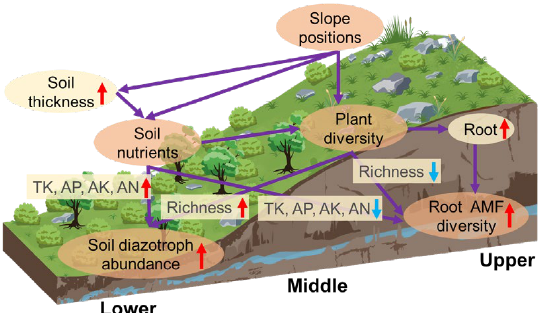
Figure 5. Conceptual model revealing the relationship between soil physiochemical property param- eters and soil diazotroph as well as root AMF at different slope positions. TK: total potassium; AN: alkali-hydrolyzable nitrogen; AP: available phosphorus; AK: available potassium. The red arrows sug- gest an increase in effect, the blue arrows demonstrated declines, and the purple arrow shows how a physical condition or chemical condition impacts chemistry, AMF diversity, or diazotroph